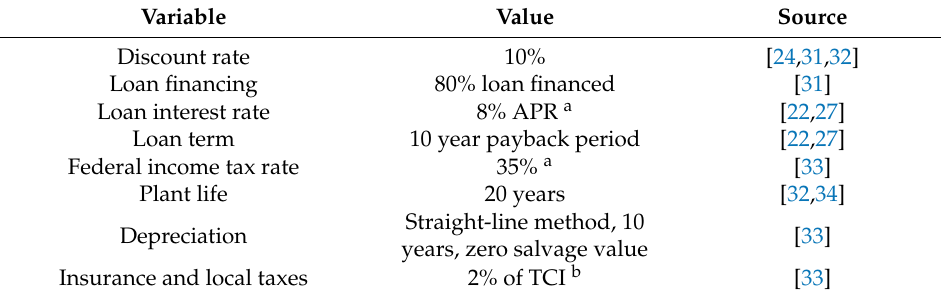
Table 2. Financial accounting